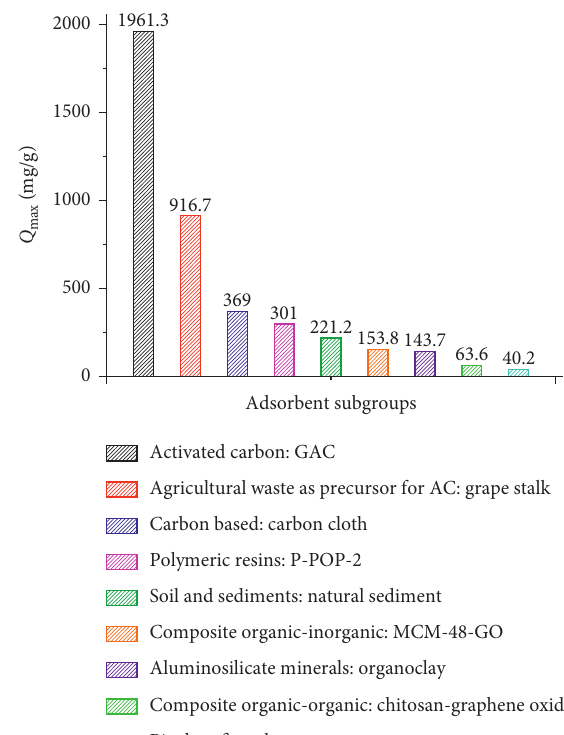
Figure 5: Maximum caffeine adsorption capacity per adsorbent subgroup.